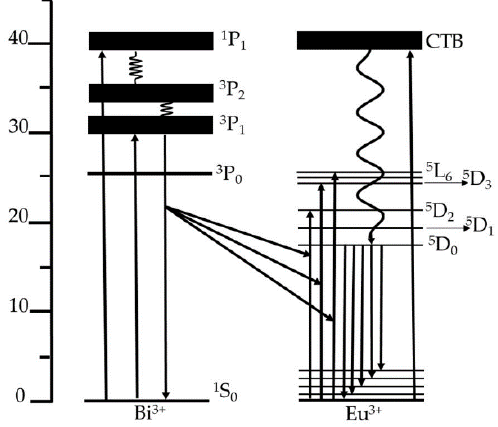
Figure 1. The partial energy diagram of Eu 3+ and Bi 3+ ions.